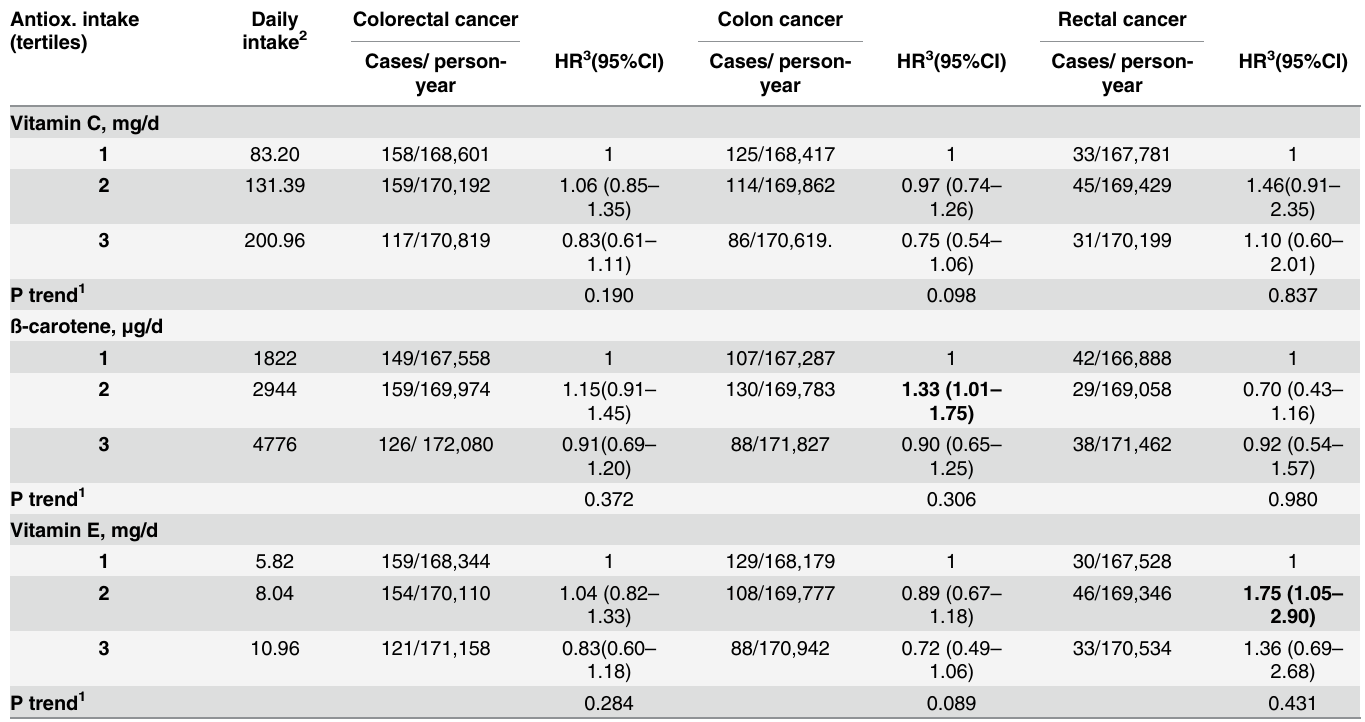
Table 3. HRs for developing colorectal cancer, colon and rectal cancer by increasing tertiles of vitamin C, ß-carotene and vitamin E intake. Antiox. intake